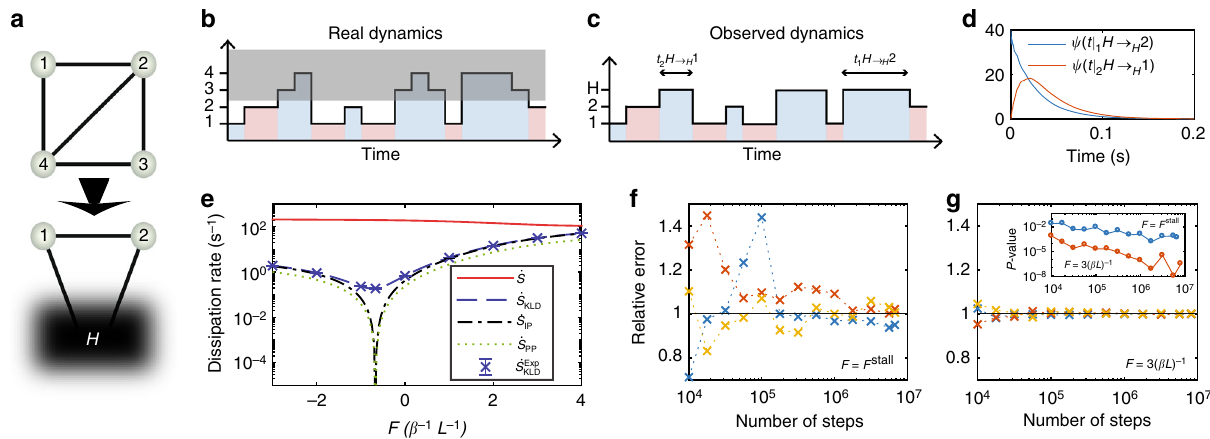
Fig. 3 Hidden network. a Four-state network, as seen by an observer, with access only to states 1, 2, H . b , c Illustration of a trajectory over the four possible states ( b ) where the gray region corresponds to the hidden part. The resulting observed semi-Markov dynamics ( c ). d Kernel density estimation of the wait time distributions at F = F stall . e Estimated total entropy production rate _ S (solid red line), entropy production for semi-Markov model _ S (dashed blue KLD curve), informed partial entropy production rate _ S (dashed-dotted black curve), the passive partial entropy production rate _ S (dotted green curve), and IP PP the experimental entropy production rate estimated according to the semi-Markov model _ S Exp (blue crosses). f , g Relative error (ratio of experimental KLD entropy production rate to analytical value) for three random trajectories as a function of the number of steps at F = F stall ( f ) and F = 3 β − 1 L − 1 ( g ) showing faster convergence away from the stalling force. Inset: p -value for rejecting the null hypothesis that the experimental data was sampled from a zero mean distribution as a function of the number of steps for F = F stall (blue curve), and F = 3 β − 1 L − 1 (red curve), showing that the average is statistically signi fi cant different from zero. The numerical simulations were done using the Gillespie algorithm with the following transition rates: ω 12 = 2 s − 1 , ω 13 = 0 s − 1 , ω 14